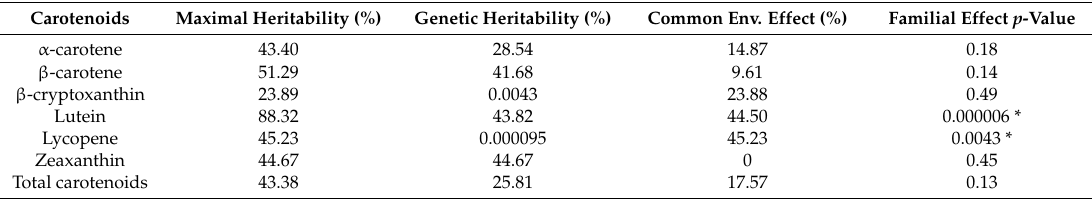
Table 2. Heritability estimates of carotenoid concentrations.